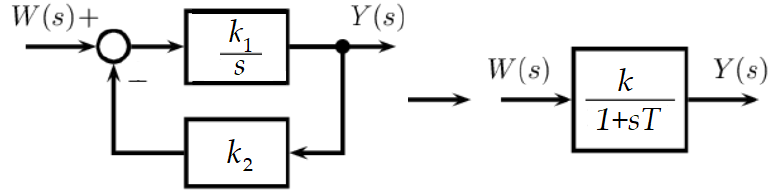
Figure 1. Model of the rocket control